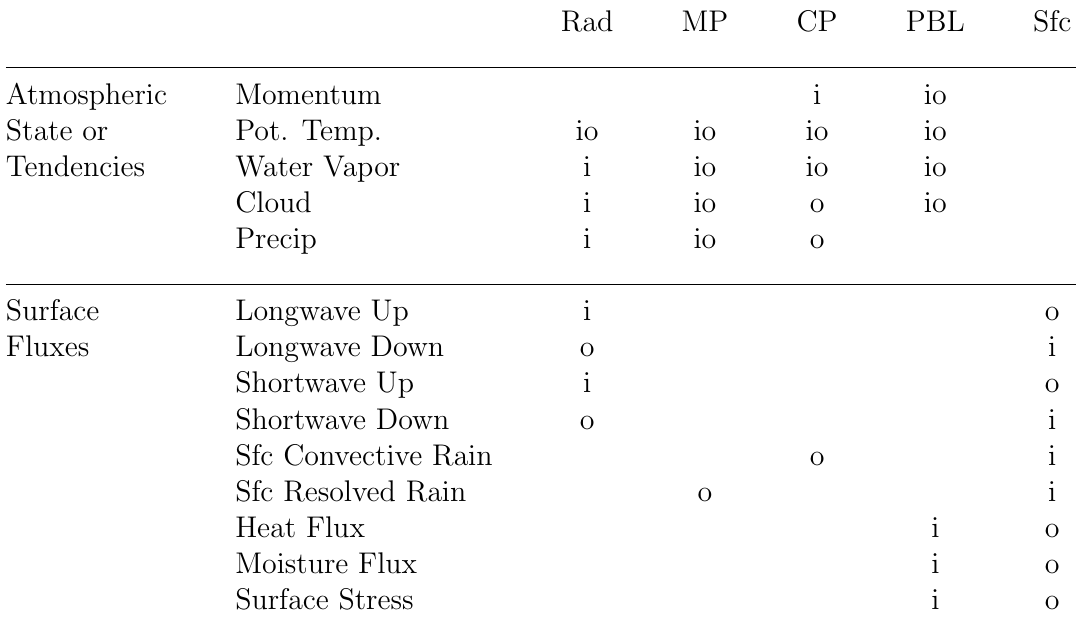
Table 8.6: Physics Interactions. Columns correspond to model physical processes: radiation (Rad), microphysics (MP), cumulus parameterization (CP), planetary boundary layer/vertical diffusion (PBL), and surface physics (Sfc). Rows corresponds to model variables where i and o indicate whether a variable is input or output (updated) by a physical